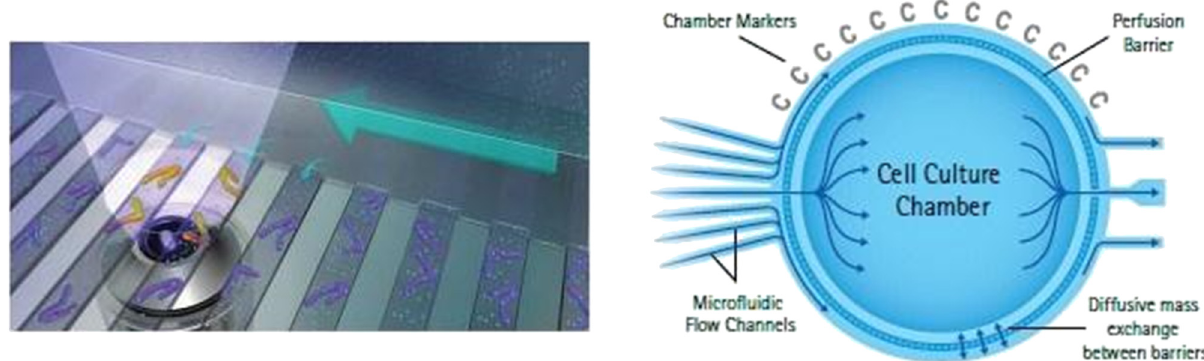
Figure 6: Left: Representation of the micro fl uidic device developed in ref. [ 44 ] for long - term imaging of bacteria, consisting of the main fl ow channel ( big blue arrow ) that di ff uses into the cell channels. Right: Scheme of the micro fl uidic chambers present in the CellASIC ONIX2 Micro fl uidic plate used in refs [ 45 – 47 ] . A membrane covers the cell culture chamber allowing mass di ff usion of liquids from the micro fl uidic channels. Images reproduced with permission from Science ( left, [ 44 ]) and from Merkmillipore webpage ( right, http://merckmillipore. com/ )